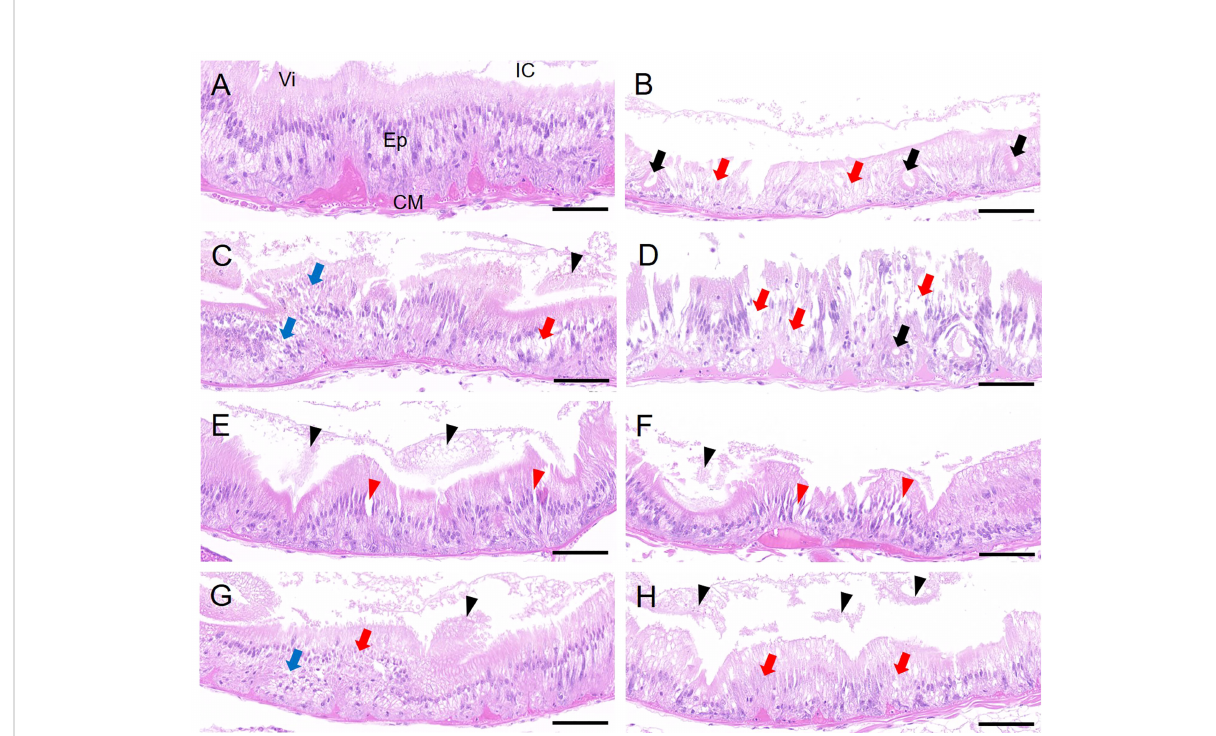
FIGURE 6 Histology (transverse section) of P. aibuhitensis intestinal canal after 7 days of exposure to (A) Control, (B) 10 m g/L PS, (C) Cd L , (D) Cd L + PS, (E) Cd M , (F) Cd M + PS, (G) Cd H , and (H) Cd H + PS. Vi, intestinal villi; Ep, intestinal epithelia; CM, circular muscle; IC, intestinal cavity. The different symbols indicate cytolysis (red arrow), vacuolation (black arrow), disordered arrangement (blue arrow), villi exfoliation (black triangle), and enlarged cell space (red triangle). Scale bars are 50 m